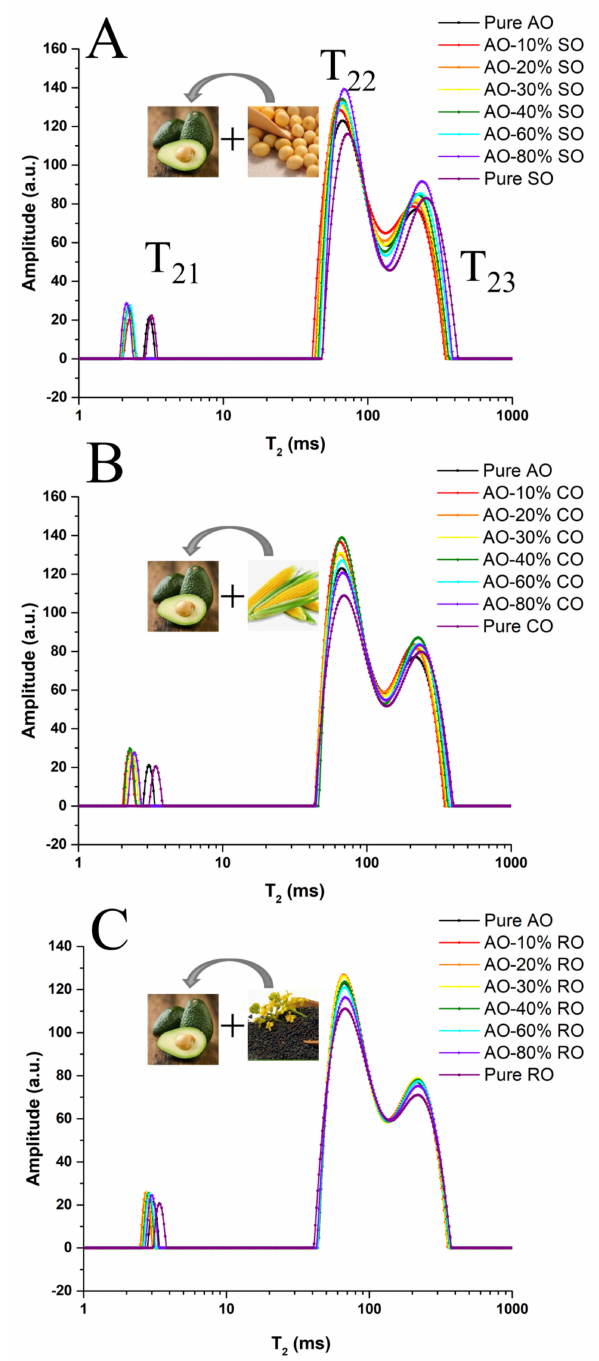
Figure 1. The T 2 distribution of AO adulterated by SO ( A ), CO ( B ) or RO ( C )